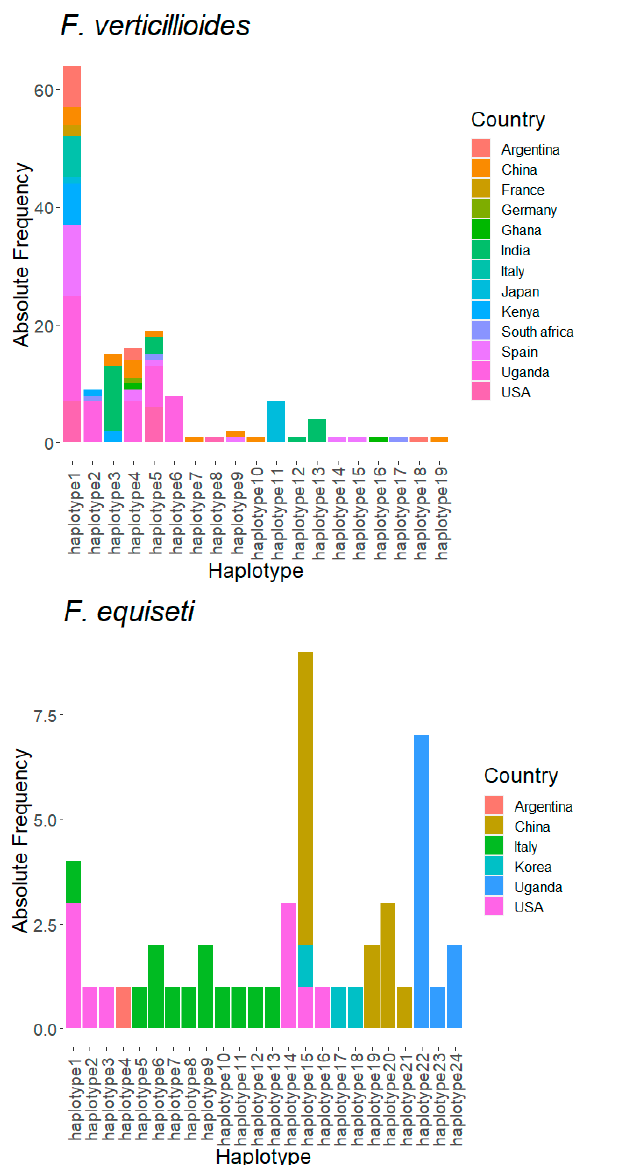
Figure 1. Distribution of different haplotypes derived from on partial sequence of translation elongation factor alpha-1 gene according to country of origin.